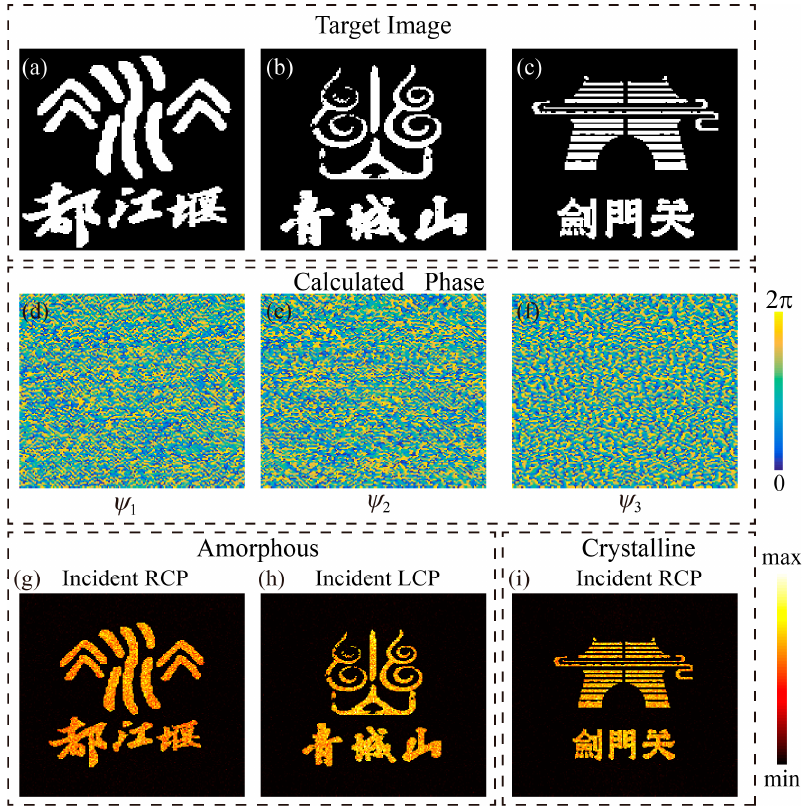
Figure 5. Multistate meta-hologram for information encryption. ( a – c ) Target images. ( d – f ) Calculated phase distributions based on GS algorithm. ( g – h ) Calculated far field results when GSST is in A-state under RCP ( g ) and LCP ( h ) incidences. ( i ) Calculated far field results when GSST is in C-state under RCP incidence.